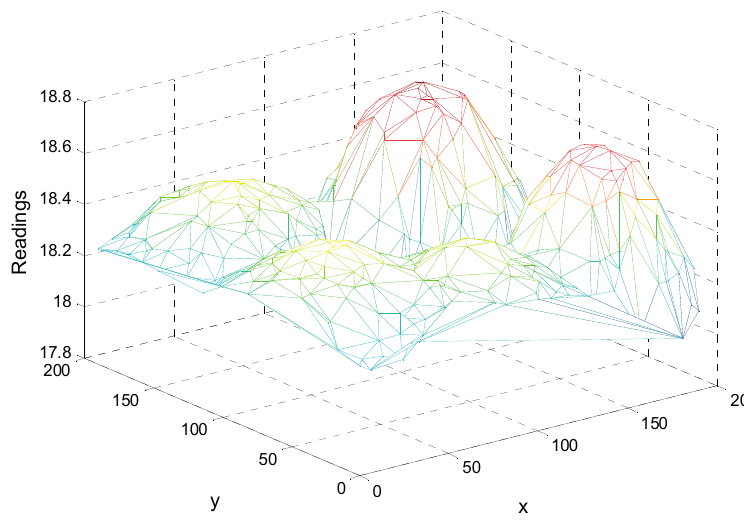
Figure 13. An example of the readings in a query round.